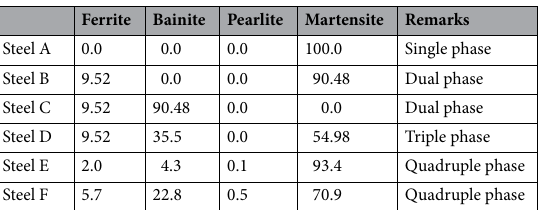
Ferrite Bainite Pearlite Martensite Remarks